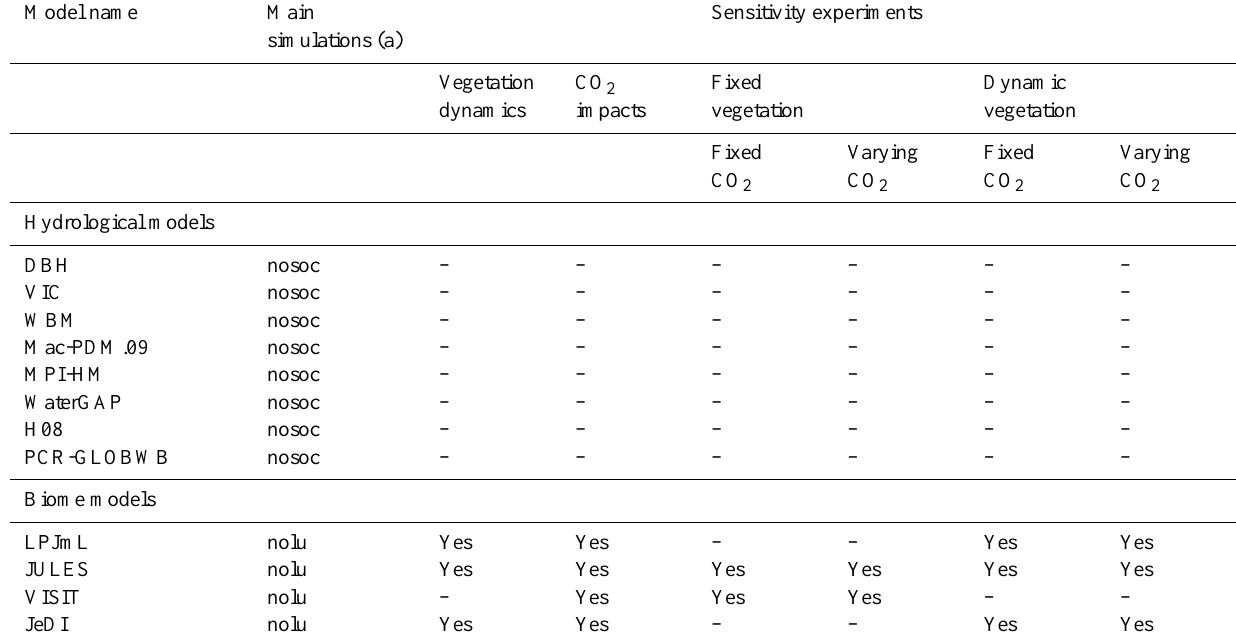
Table 2. Model simulations analysed in the present study (all driven by ISI-MIP forcing data for HadGEM2-ES historic and RCP8.5 scenar- ios) – (a) nosoc: naturalized runs, with no human impact, no irrigation, and no population/GDP data prescribed; nolu=no human land use